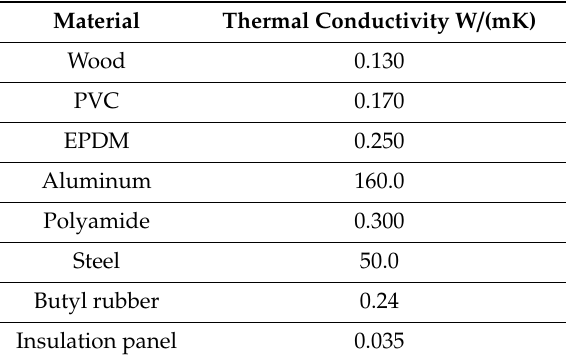
Table 1. Material thermal conductivities .